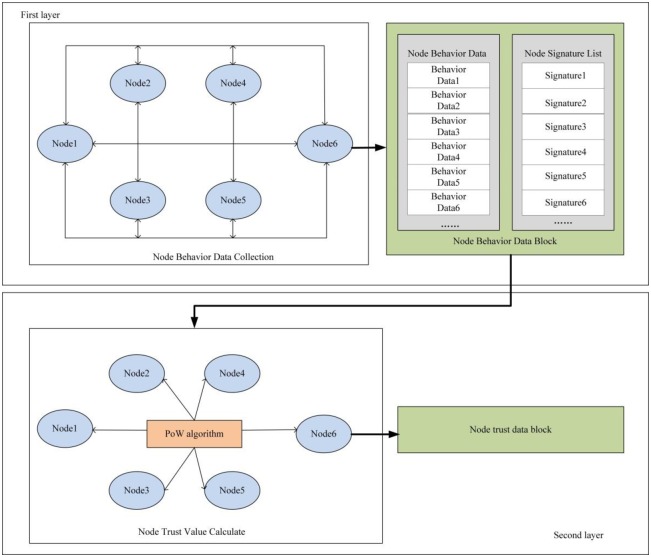
Two-layer blockchain structure.